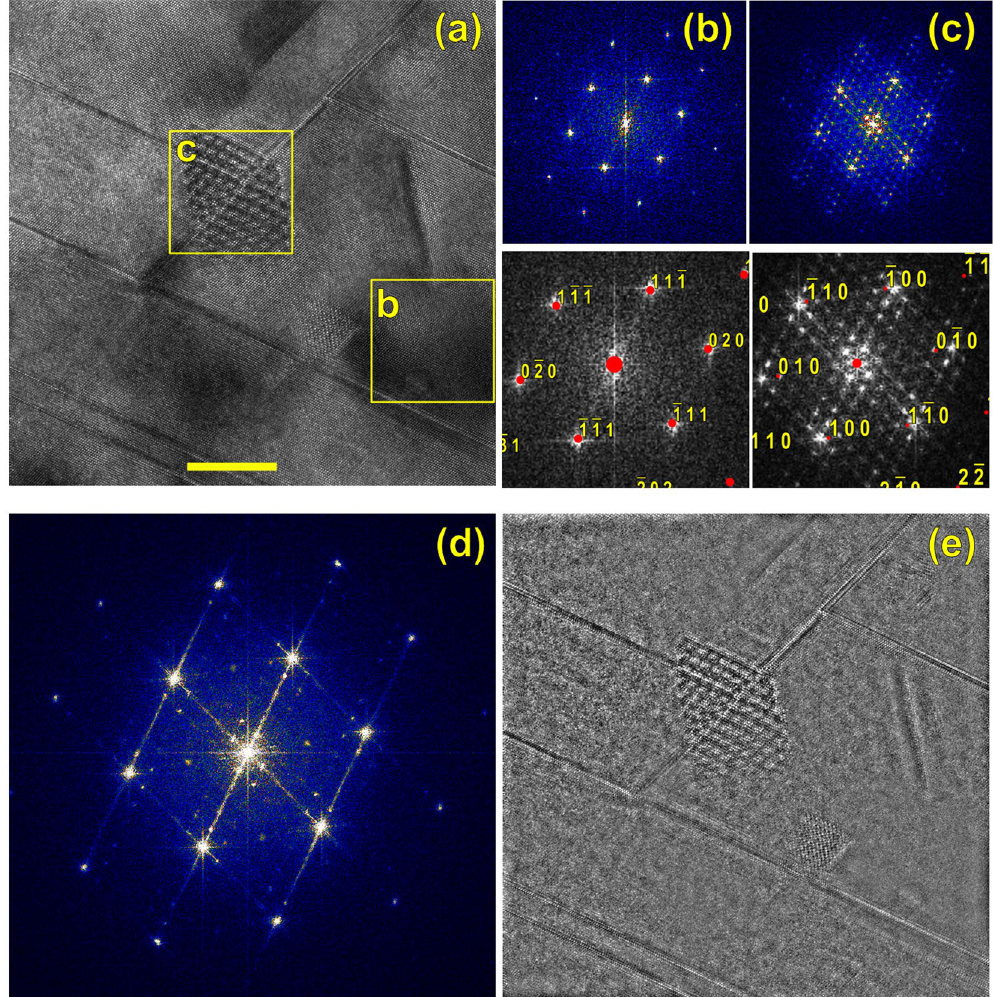
Figure 5. HRTEM image on the [101] matrix zone. Boxes marked “b” and “c” denotes the Fourier transforms of ( b ) and ( c ), which also show calculated diffraction patterns for 3C and 6H SiC. ( d ) The Fourier transform of the entire image, showing dislocation streaks, cubic spots, and precipitate spots. ( e ) Inverse Fourier transform after the cubic spots were removed from ( d ); only the precipitates and dislocations remain. Scale bar 10